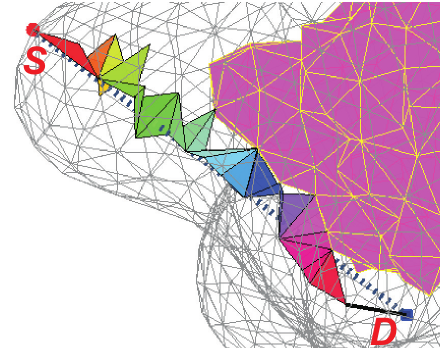
Figure 5. A packet is routed through a sequence of faces under face-based greedy